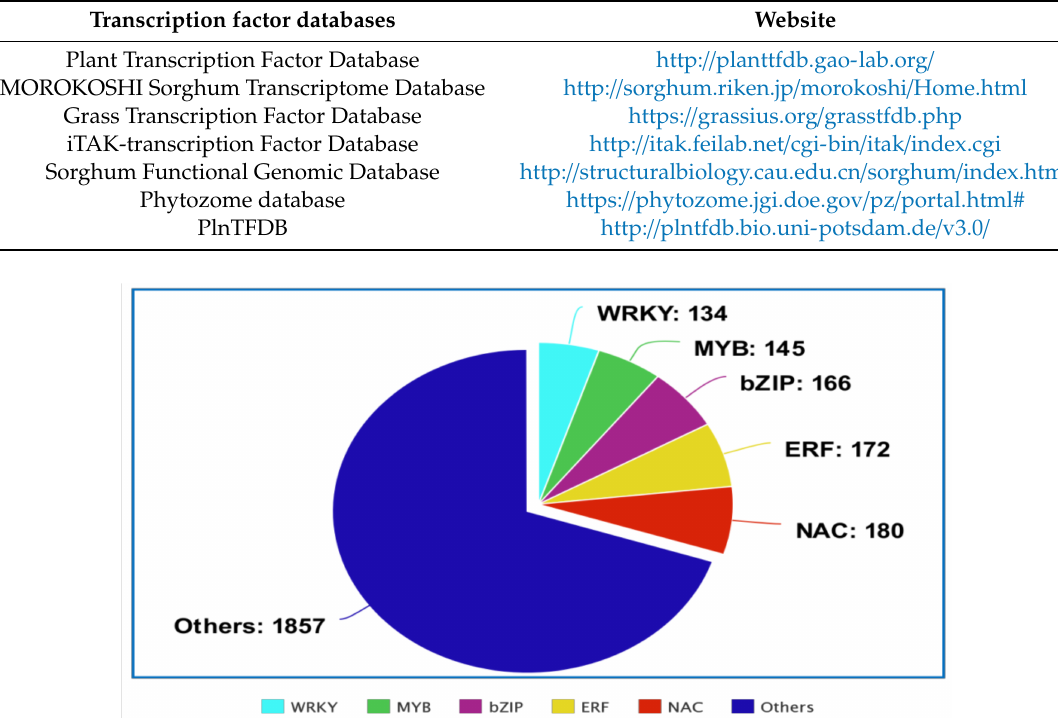
Table 1. Plant transcription factor databases.